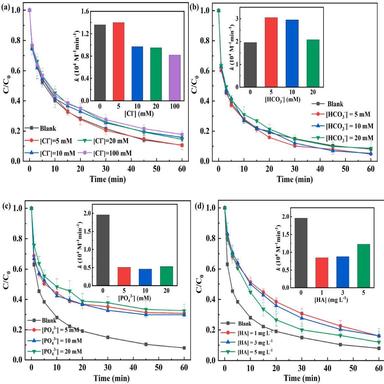
Effects of water matrices on degradation of phenol in CPANI/PAA system: (a) Cl− , (b) HCO3 − , (c) PO4 3− and (d) HA. Experimental conditions: = 25 mg L− 1 , = 10 μM, = 0.1 mM, = 5–100 mM, = 5–20 mM, = 5–20 mM, = 1–5 mg L− 1 and initial pH of 7.0.